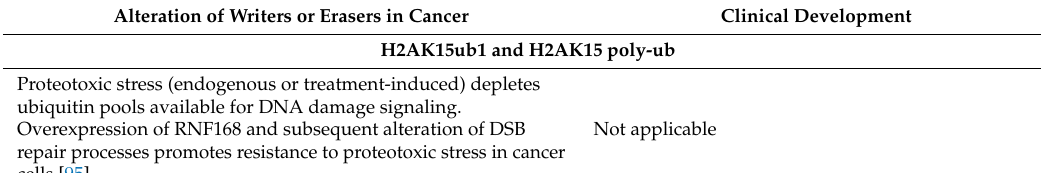
Table 3. Functions of histone H2A and H2B ubiquitination marks in